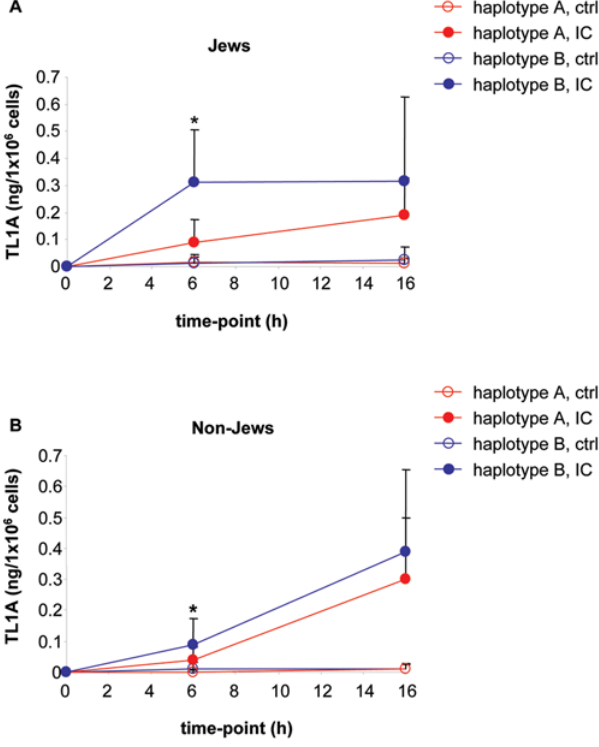
Figure 2. The B risk haplotype is associated with increased TL1A secretion in CD patients. Monocytes from Jewish and non- Jewish patients with A, or B haplotypes were stimulated with IC for 6 or 16 h. Cell culture supernatants were analyzed for TL1A secretion by ELISA. ( A ) Monocytes from Jewish patients with A or B haplotypes were stimulated with IC for 6 or 16 h (n=15 and 12 for haplotype A and haplotype B , respectively, *, P # 0.002). All data represent the mean 6 SD. ( B ) Monocytes from non-Jewish patients with A or B haplotypes were stimulated with IC for 6 or 16 h (n=13 and 15 for haplotype A and haplotype B , respectively, *, P # 0.05). doi:10.1371/journal.pone.0004719.g002 post stimulation (Figure 4C, p = 0.14 for 6 h IC stimulation), suggesting different kinetics in the TL1A secretion in Jewish vs. non-Jewish CD patients in response to Fc c R signaling. We did not observe any differences in TL1A secretion in non-Jewish OmpC 2 patients with the B haplotype compared to patients with haplotype A (Figure 4D, p = 0.21 for 16 h IC stimulation). Next, we analyzed the surface expression of TL1A in Jewish OmpC + patients with different haplotypes by flow cytometry (Figure 5). We observed a significant increase in the proportion of TL1A + monocytes in untreated monocytes from Jewish patients carrying the B haplotype compared to patients with the A haplotype in Jewish patients regardless of their OmpC status (Figure 5A, B). Similar differences were not seen in non-Jewish patients (Figure 5C, D, p = 0.37 and p= 0.43 for non-Jewish OmpC + and non-Jewish OmpC 2 patients, respectively). Surprisingly, we could not observe any differences in the percentage of monocytes expressing TL1A stimulated with IC between different haplotypes (Figure 5A, B, p= 0.31). However, the mean fluorescence intensity (MFI) was significantly increased in IC stimulated monocytes in Jewish OmpC + patients carrying the B haplotype compared to A carriers (Figure 5A) but not in Jewish OmpC 2 patients (Figure 5B, p = 0.35). We did not observe any significant differences in surface expression of TL1A in untreated or IC stimulated monocytes between A and B carriers in non-Jewish patients (Figure 5C, D,